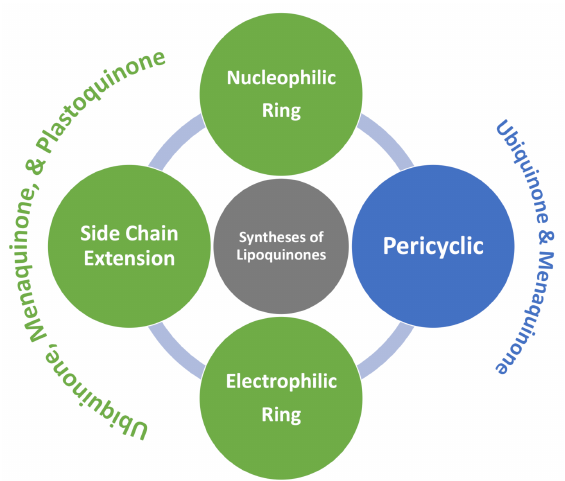
Figure 14. Synthetic methods used to synthesize